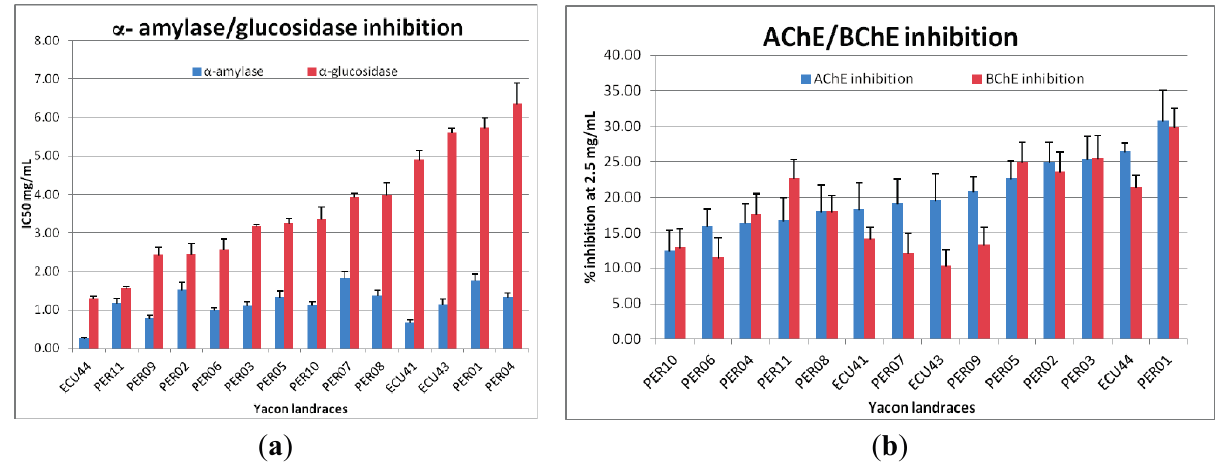
Figure 1. ( a ) α -Amylase and α -glucosidase inhibition activity and ( b ) acetylcholinesterase (AChE) and butyrylcholinesterase (BChE) inhibition of tested yacon